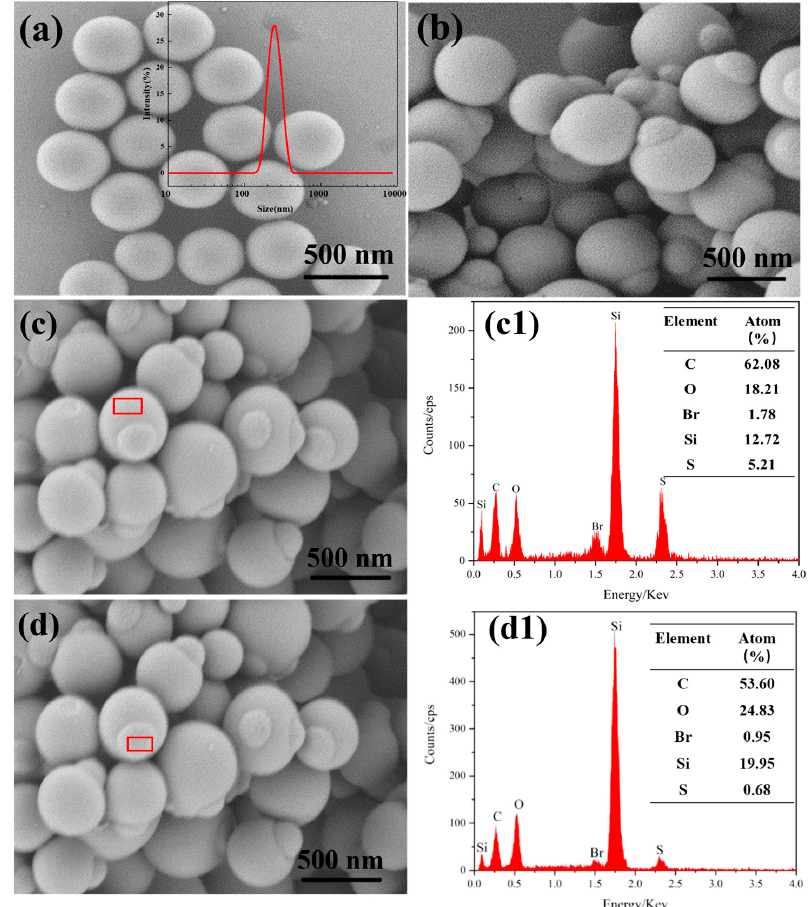
Figure 2. Scanning electron microscopy (SEM) image and corresponding particle size distribution measured using dynamic light scattering (DLS) (inset) of ( a ) SiO 2 microspheres; ( b – d ) SEM images of snowman-like SiO 2 @MPSQ particles with the corresponding ( c1 ) and ( d1 ) X-ray diffraction energy-dispersive spectra (EDS).